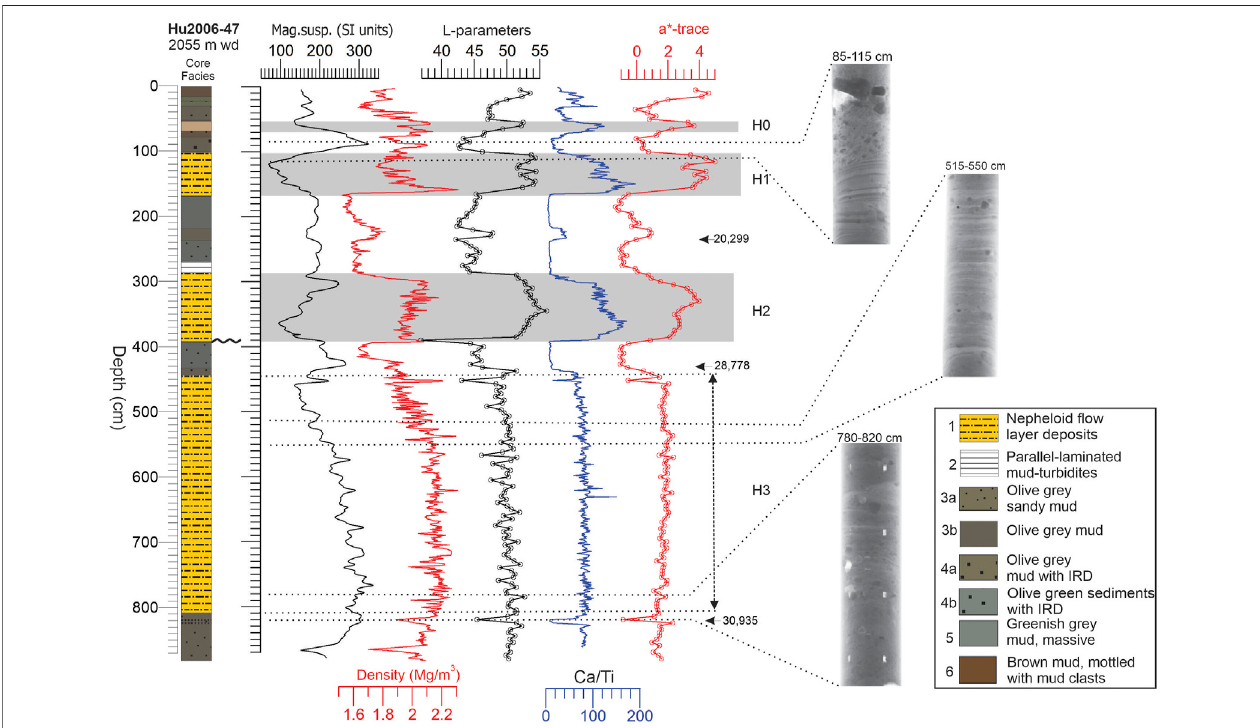
FIGURE3 | Magnetic susceptibility and density ofbulk sediments, sediment color L*, Ca/Ti ratios, a*-trace, X-radiographs, and core photographs werecombined to assign sediment facies of core Hu2006040-47. Three 14 C-AMS dates, shown by black arrows, ascertain the identi fi cation of H1 and H2 layers between 102 and 168 cm and 286 and 392 cm, respectively. Three representative X-radiographs show sedimentary structures of H2, and H3 layers (515 – 550 cm and 780 – 820 cm) are also illustrated on the right.